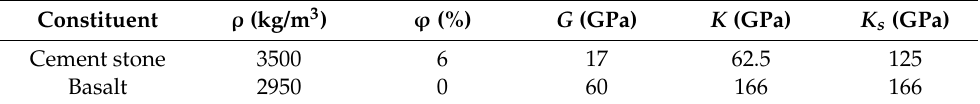
Table 1. Physical and mechanical characteristics of the constituents of the model high-strength concrete.